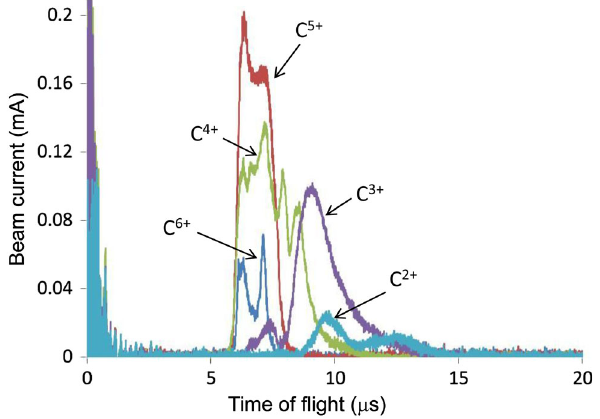
FIG. 4. Spectrum of carbon ions.